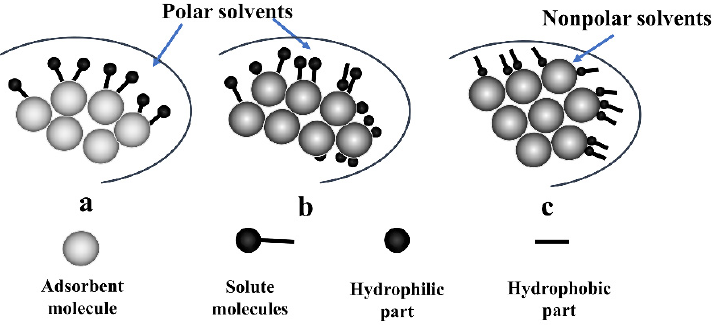
Figure 7. Schematic diagram of adsorption action of large-grid adsorbent. ( a ) In polar solvents, the adsorption of non-polar adsorbents. ( b ) In polar solvents, the adsorption of moderately polar adsorbents. ( c ) In non-polar solvents, the adsorption of moderately polar adsorbents. Japanese patent (No. 51-048519) provided a method for a complete separation of Rh- phosphine complexes from high-boiling-point or gelatinous distillation residues formed by organic reaction [88]. The Rh phosphine complex catalyst is adsorbed and separated